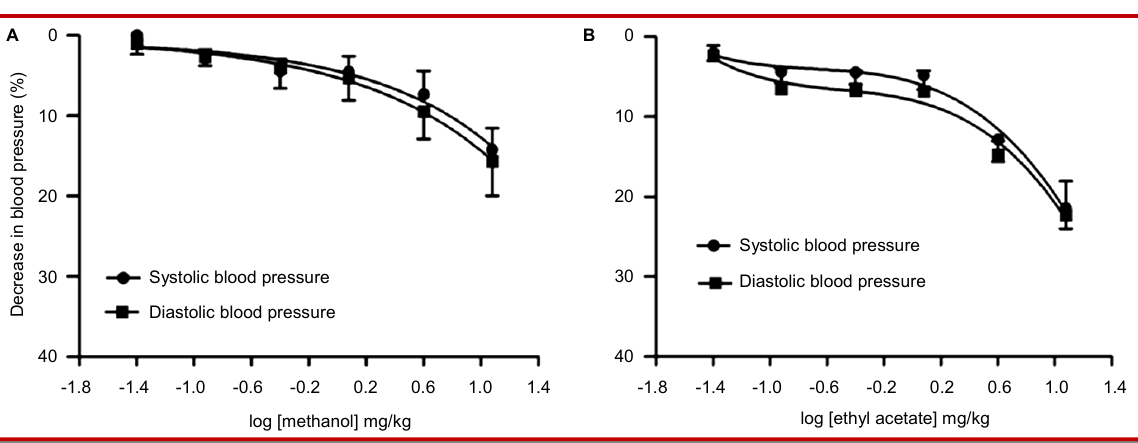
Figure 3: Concentration-response curves of methanol and ethyl acetate extract of O. glandulosum on systolic and diastolic blood pressure of anesthetized rats. Values are means ± SEM (n =